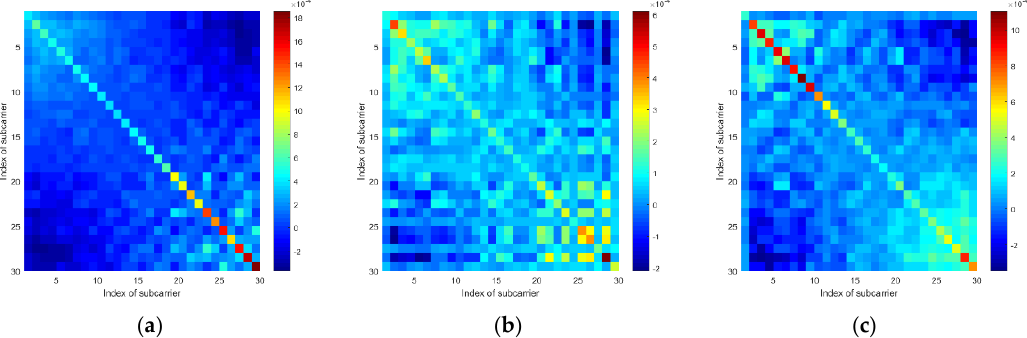
Figure 10. The CSI sanitized phase’s covariance matrices of 3 different communication links: ( a ) Link 1, ( b ) Link 2, and ( c ) Link 3.